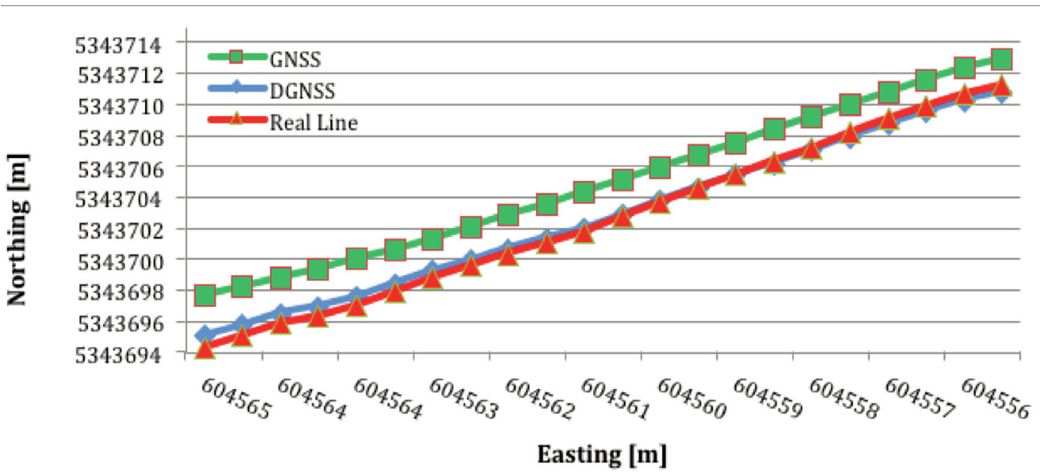
Figure 8. Deviation between the straight line path and the actual path obtained using the GNSS and DGNSS